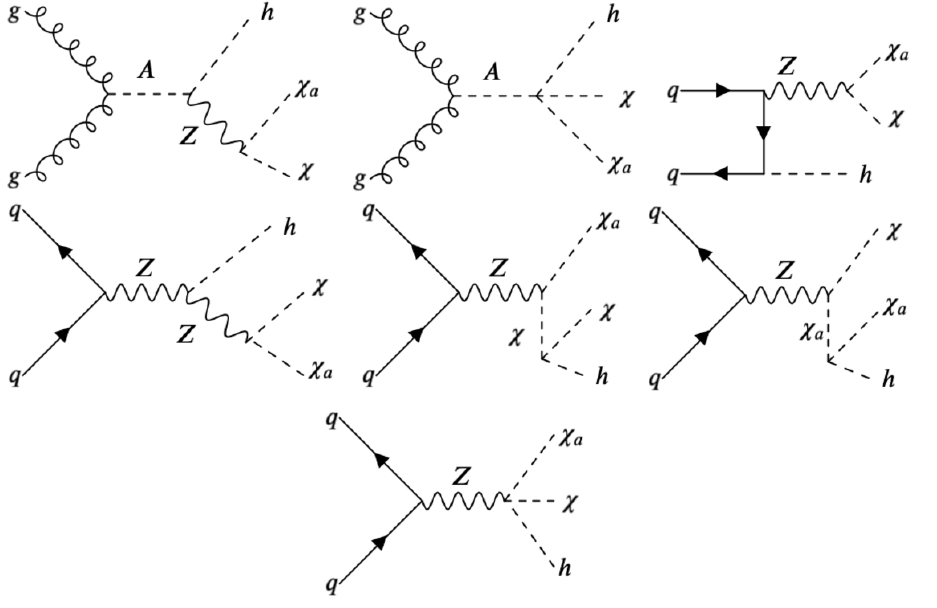
Figure 11 . Feynman diagrams contributing to the mono-Higgs production via the process pp ! (cid:31)(cid:31) a h